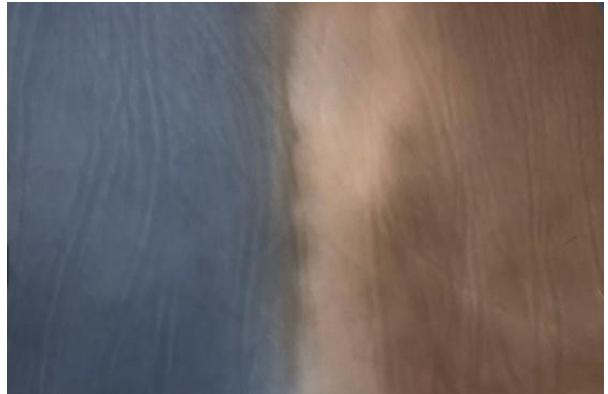
Figure 15. Flat leather before polishing.